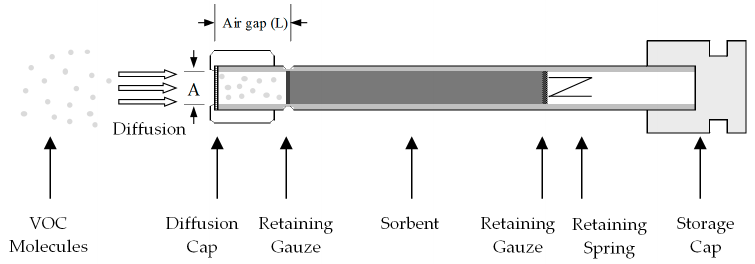
Figure 1. Structure and geometry of the standard automated thermal desorption (ATD) tube type passive sampler. VOC: volatile organic compound.